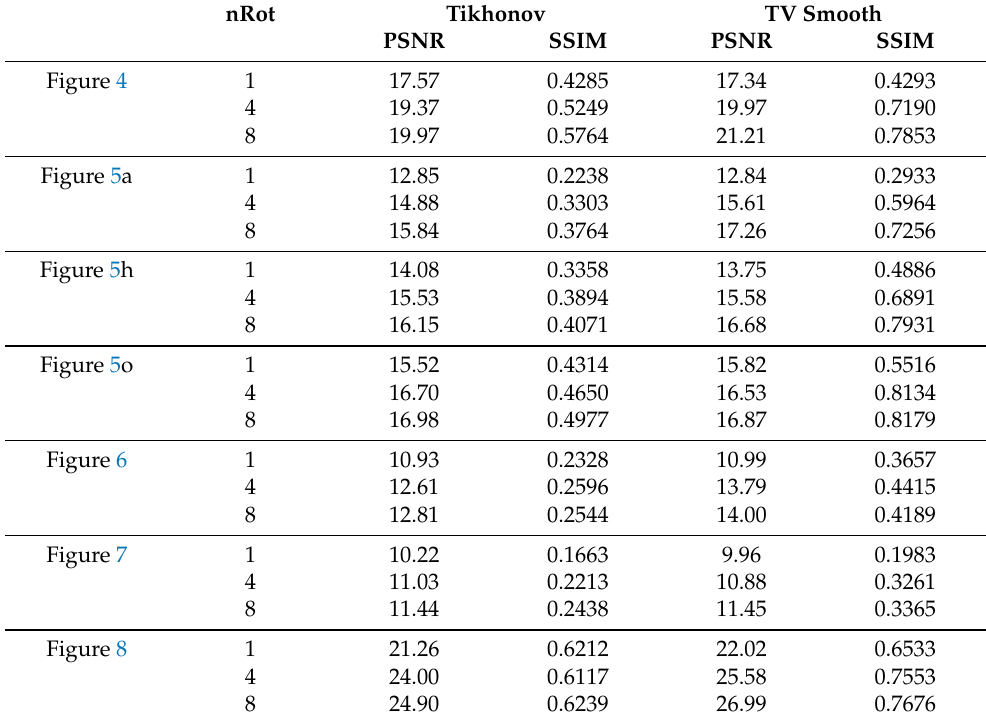
Table 2. Summary of the PSNR and SSIM scores of all